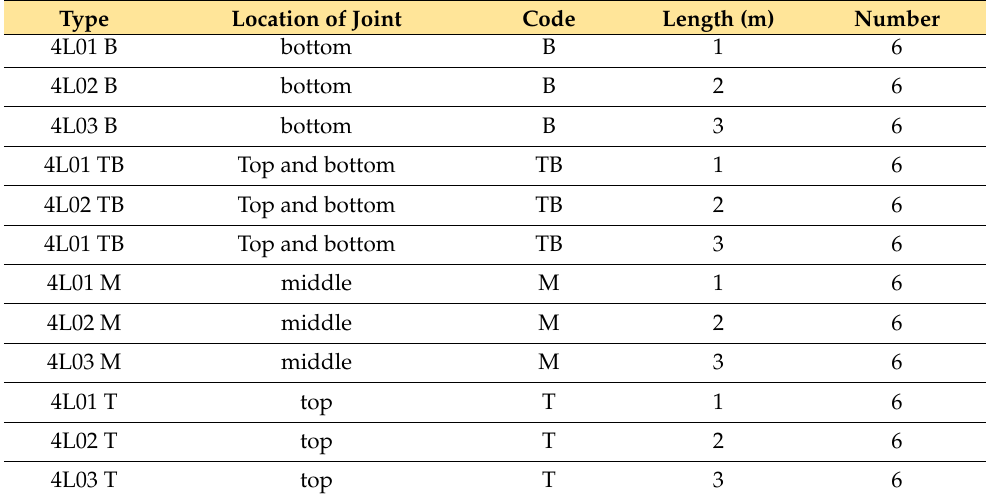
Table 2. Specimen